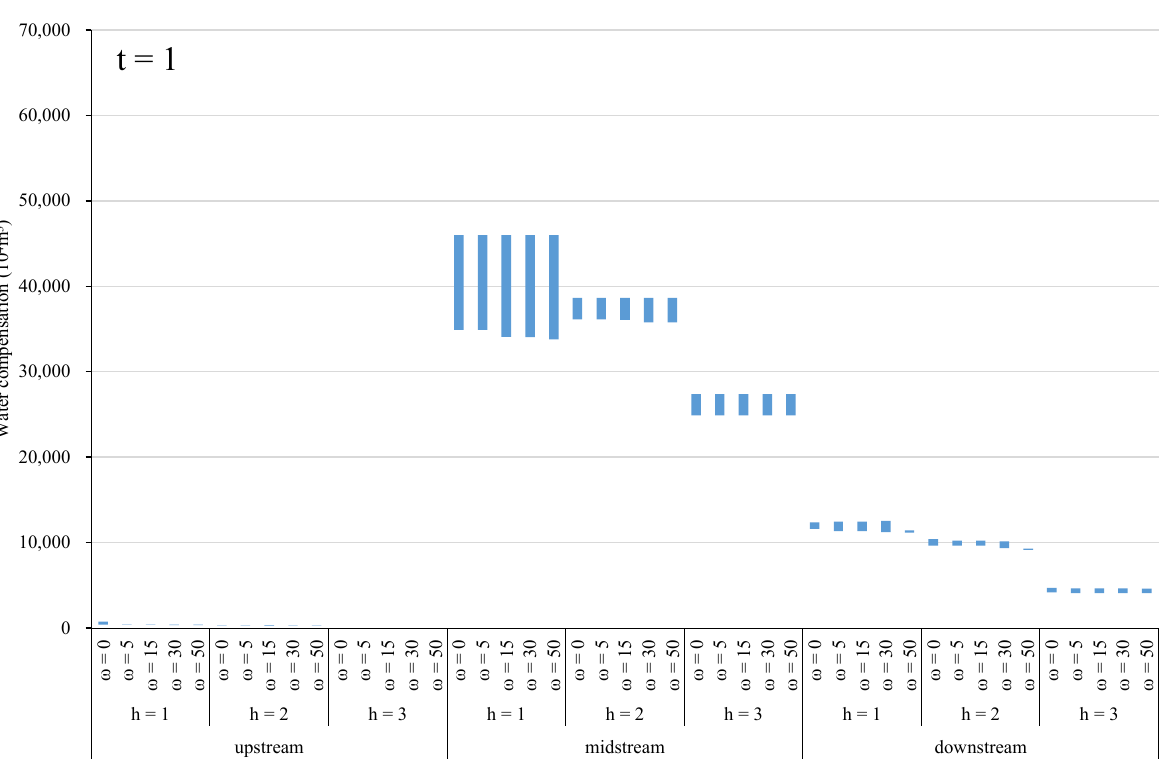
Figure 5. Water compensation by region in the Fenhe River Basin in period 1.